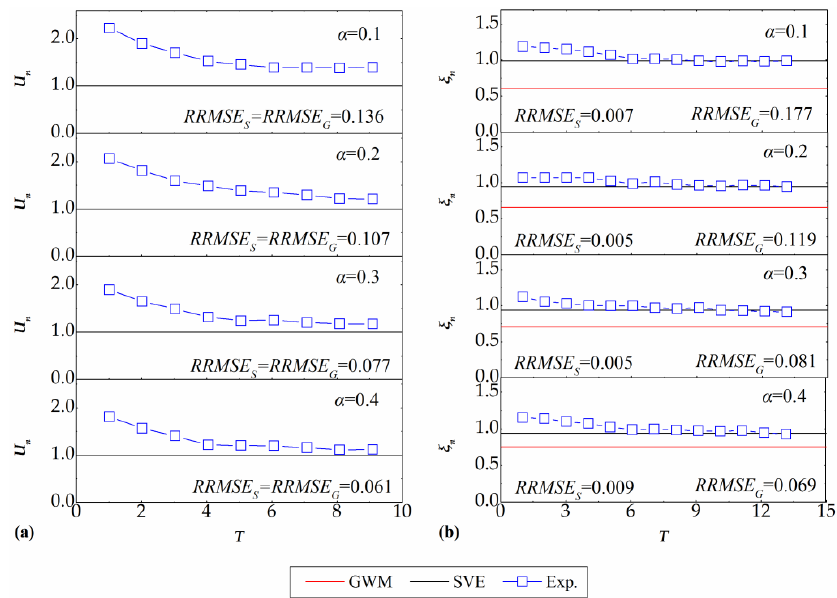
Figure 13. Upstream negative wave and downstream shock wave velocities for wet bed downstream.